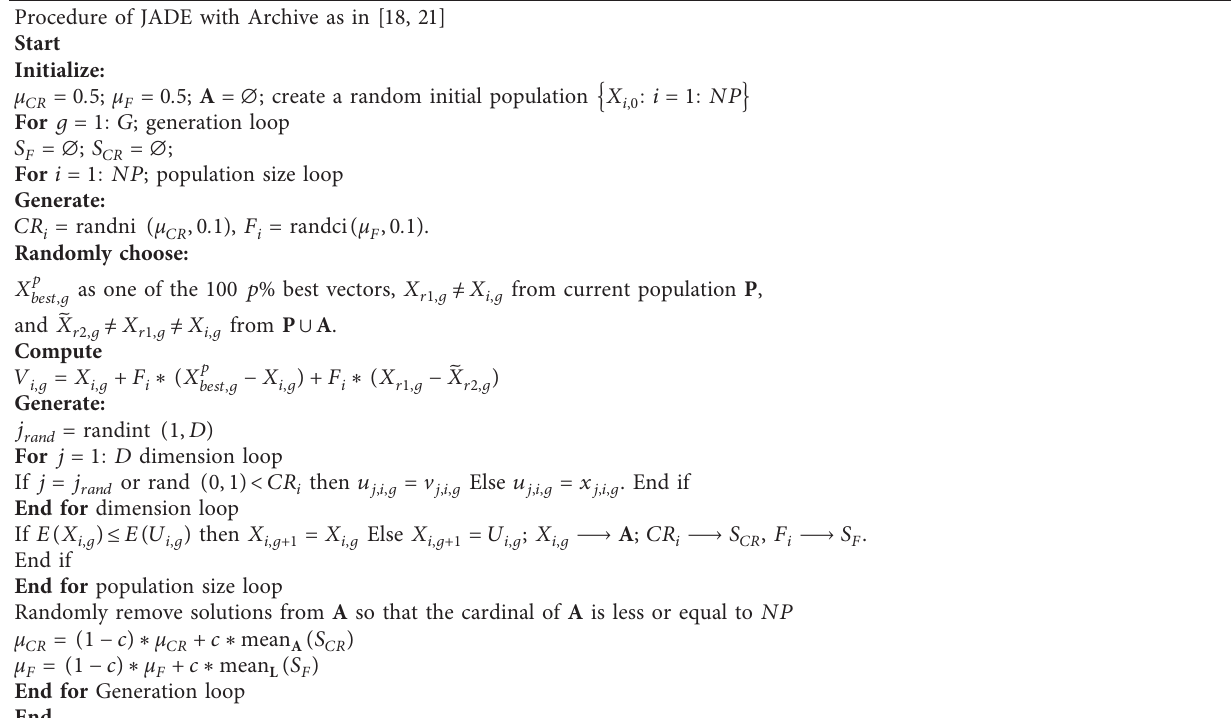
Table 1: Procedure of JADE with Archive and its description.